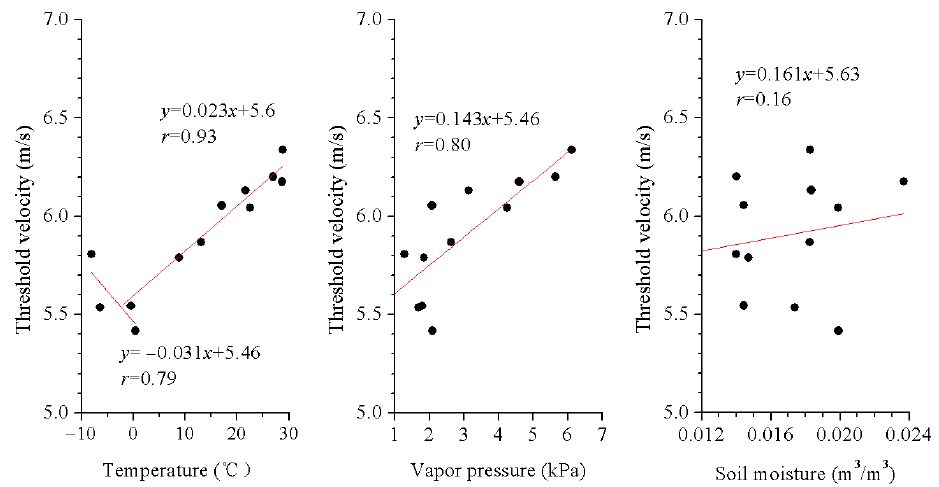
Figure 10. Correlations between monthly threshold velocity and temperature, vapor pressure, and soil moisture.